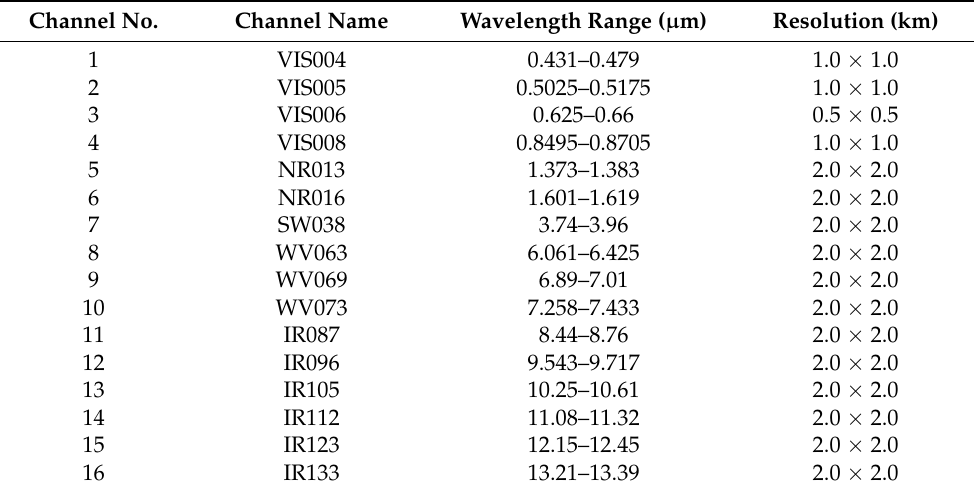
Table 1. Specifications of the GEO-KOMPSAT 2A Advanced Meteorological Imager (GK2A/AMI) spectral channels. Channel